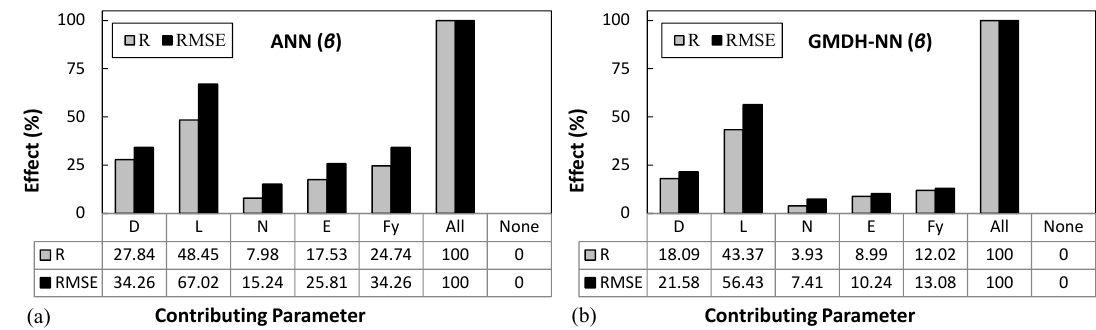
Figure 21. The effect of the input parameters on β estimation by considering R and RMSE values in proposed models: ( a ) ANN; ( b ) GMDH-NN.